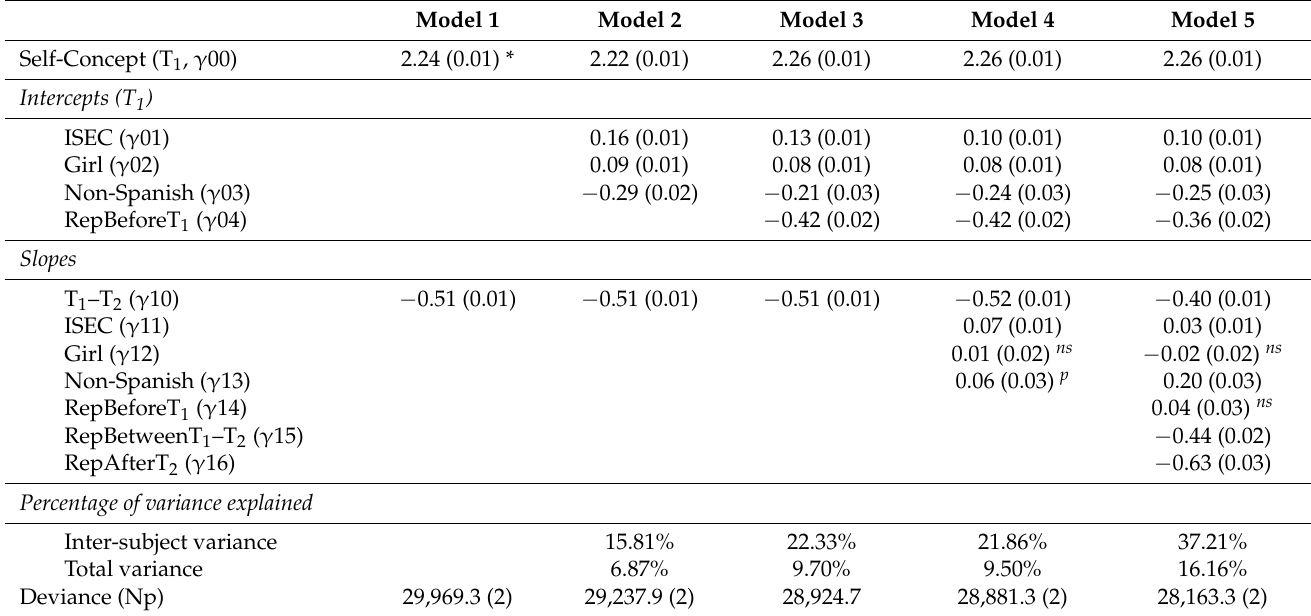
Table 2. Adjusted hierarchical regression models for academic self-concept between time-point 1 and time-point 2. Model 1 Model